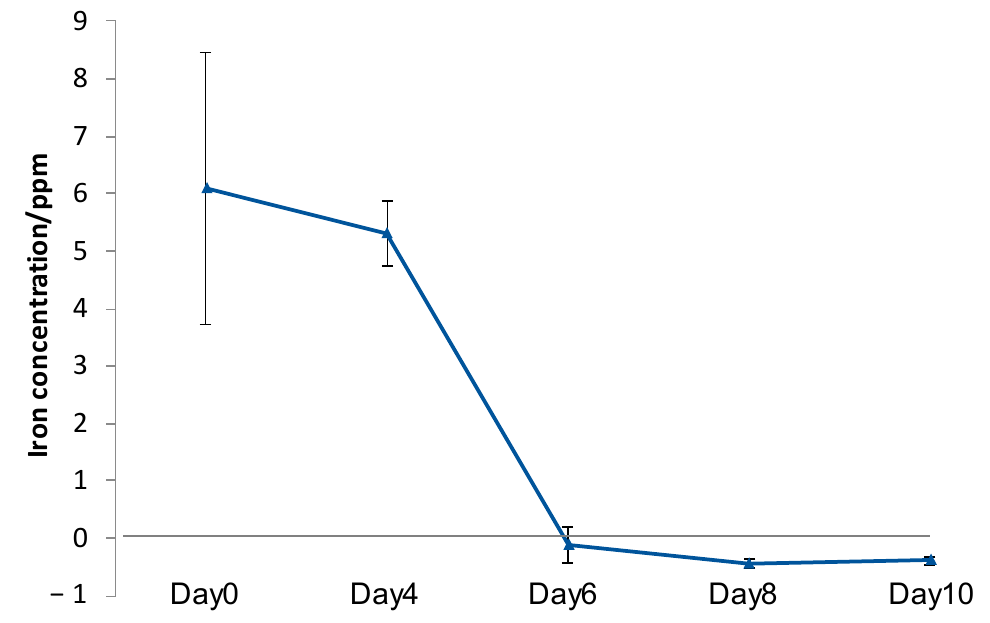
Figure 7. Iron concentrations eluted in medium (day 0) and seawater (day 4, 6, 8, 10). When CSMS was incubated with TO1 culture, iron elution was not detected after 6 d, and it did not restore after 8 and 10 days. (Means ± SD, n = 6).